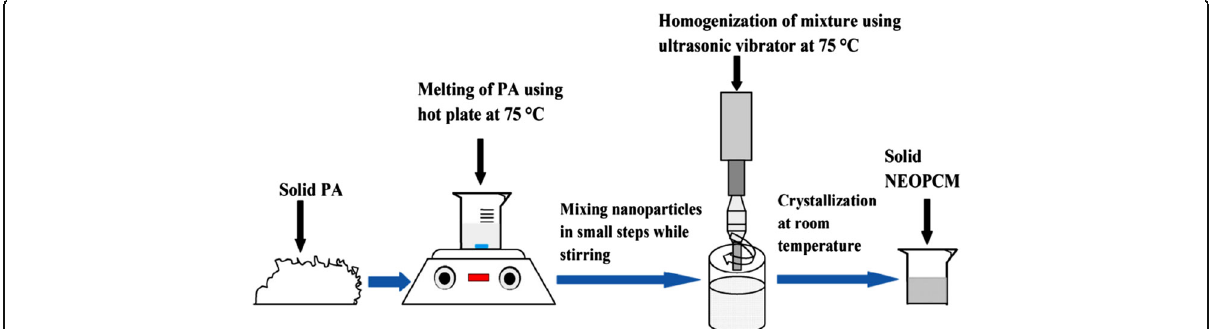
Fig. 9 Preparation steps of PA – TiO 2 composites [106]. Reproduced with permission from Elsevier